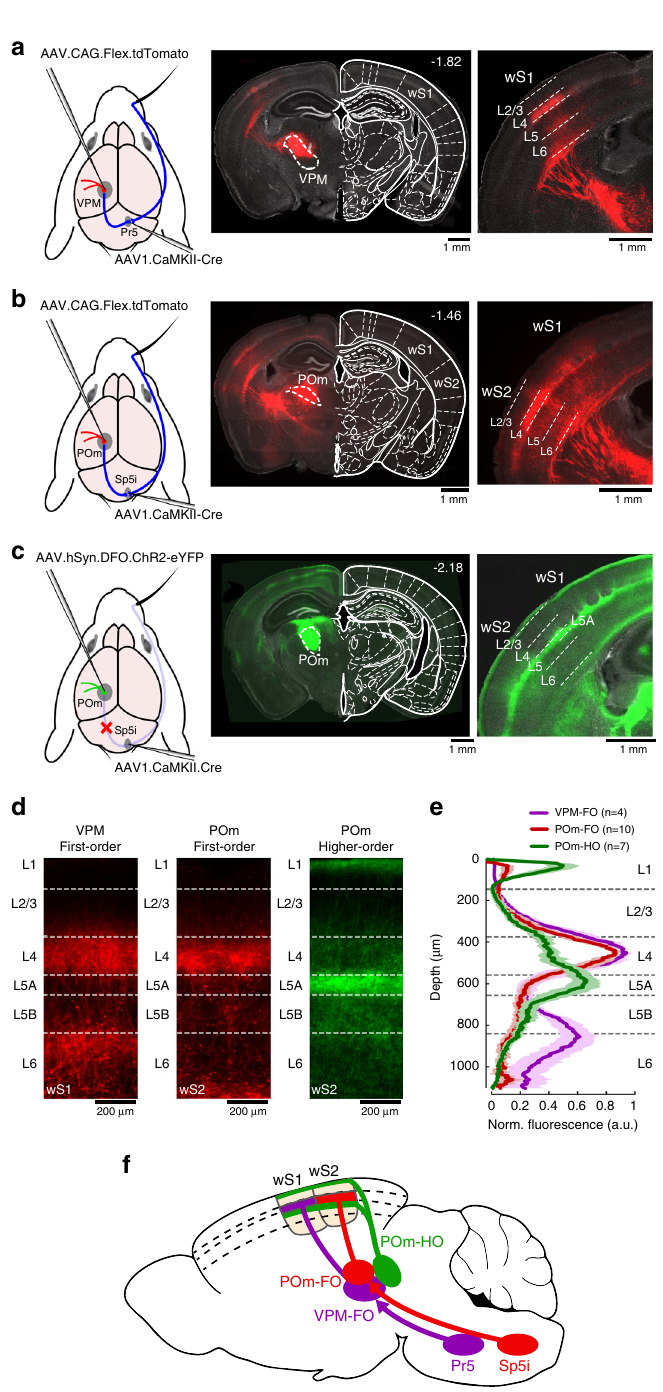
Fig. 1 Whisker somatosensory thalamic nuclei and their cortical projections revealed through AAV-mediated anterograde trans-synaptic gene expression. a AAV1 viral vector was injected in Pr5 of the brainstem to express Cre-recombinase in a trans-synaptic anterograde manner. A second AAV injection in the thalamus expressing a Cre-dependent tdTomato fl uorescent protein resulted in labeling of VPM neurons receiving direct inputs from Pr5. Left: schematic of the injection protocol. Middle: Example coronal section with VPM neurons expressing tdTomato in comparison to a reference atlas 22 (distance from bregma indicated). Right: Axonal innervation of VPM neurons in wS1. This experiment was repeated in four mice with similar results. b Same as a , but for POm neurons receiving direct inputs from Sp5i. This experiment was repeated in ten mice with similar results. c Same as b , but for POm neurons not expressing Cre-recombinase through trans-synaptic transfection from Sp5i injections. Here, the second viral vector injected in the thalamus only allowed expression of eYFP conditionally on the absence of Cre-recombinase. This experiment was repeated in seven mice with similar results. d Examples of laminar-speci fi c axonal innervation in somatosensory cortices originating from different thalamic nuclei. e Normalized fl uorescent expression pro fi le averaged over mice ( n = 4 mice for VPM fi rst-order (VPM-FO), n = 10 mice for POm fi rst-order (POm-FO), n = 7 mice for POm higher- order (POm-HO)). Shaded areas: s.e.m. f Schematic of the different somatosensory thalamocortical circuits. The schematic drawings of the brain in panels a – c are reproduced from Paxinos and Franklin (2001) with permission from